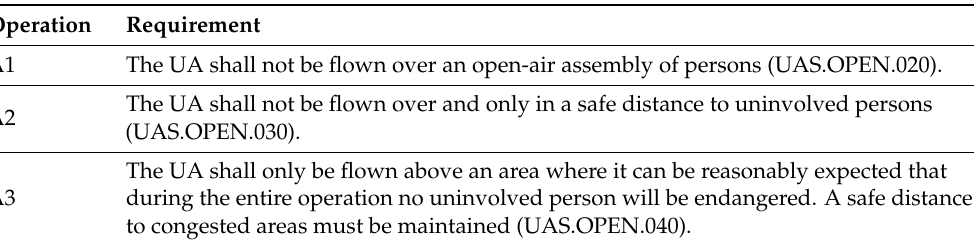
Table 4. Protection of people on the ground